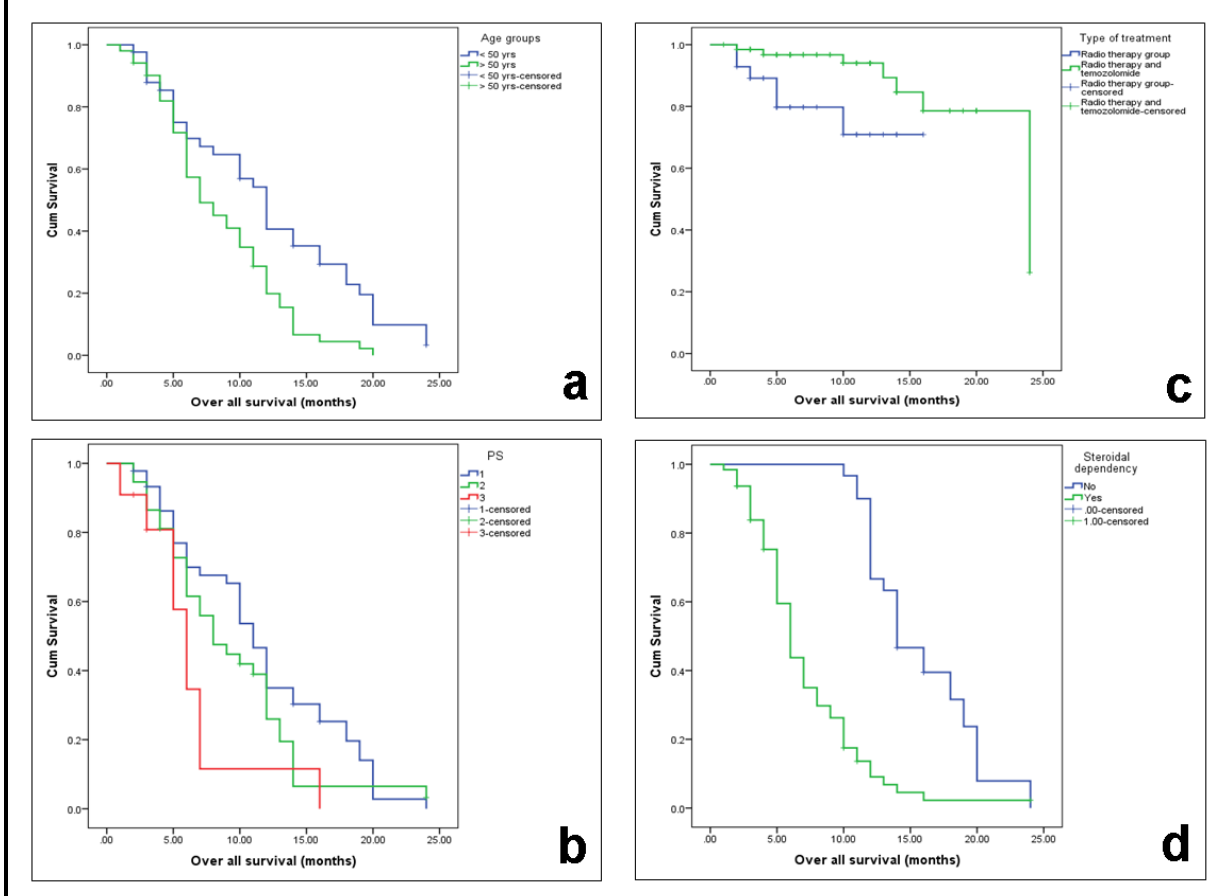
Figure 4: Kaplan-Meier progression-free survival curves according to: a) age, b) performance status, c) type of post- operative treatment and d) steroidal dependency Surgical resection of malignant gliomas remains one of the most important prognostic factors. In a clinical trial, the absence of postoperative enhancing lesion by magnetic resonance imaging (MRI) significantly improved survival (median OS 17.9 vs. 12.9 months for residual disease by MRI, p < 0.001) 13 . This data is similar to our data where patients who underwent surgical excision had a median OS of 22 months compared to 14 months for those who underwent